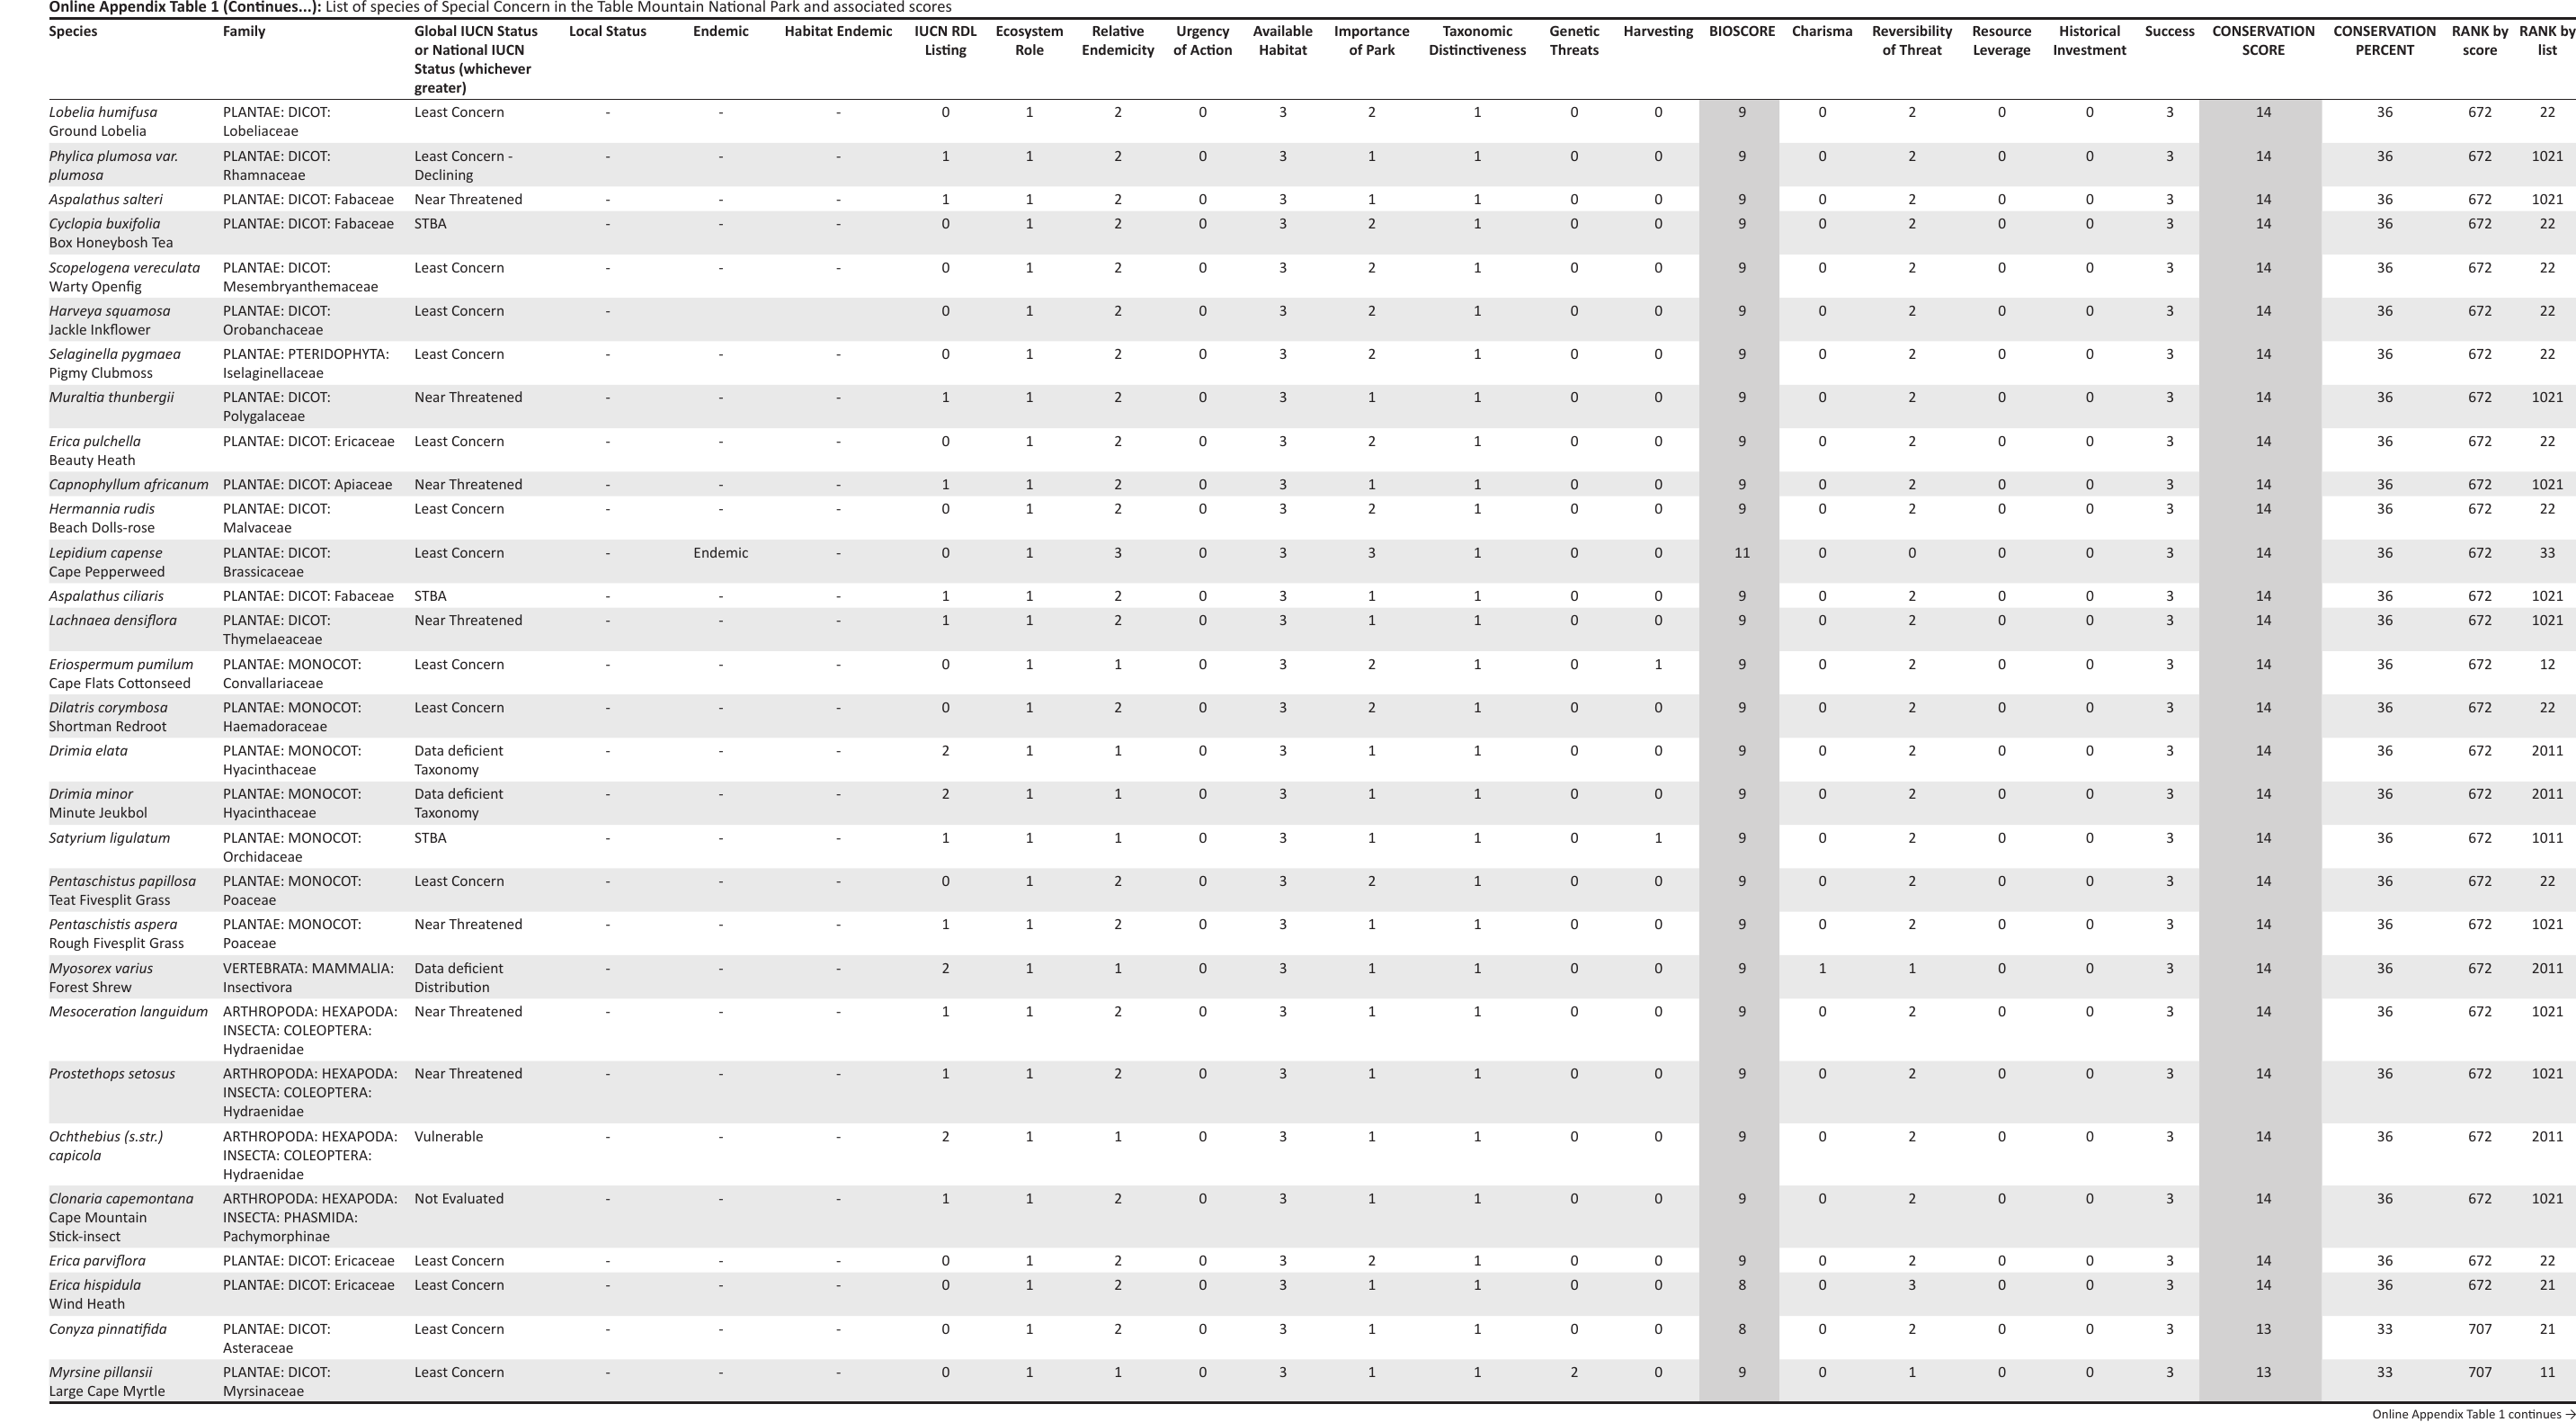
Online Appendix Table 1 (Continues...): List of species of Special Concern in the Table Mountain National Park and associated